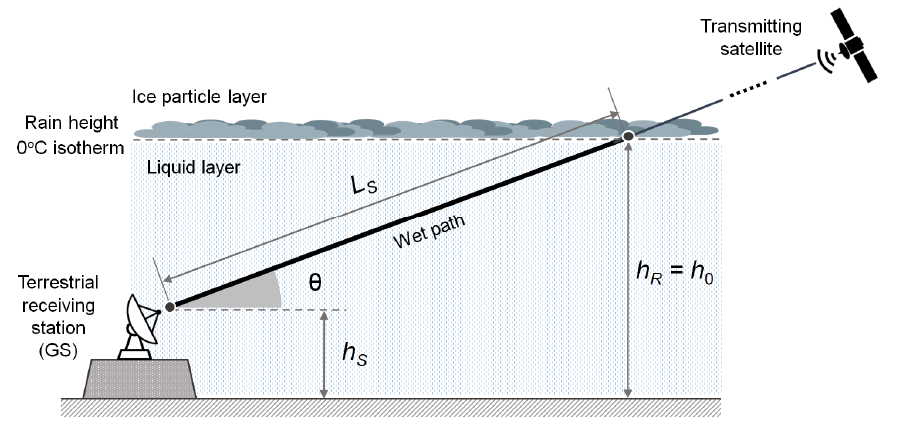
Figure 1. Satellite downlink geometry in the presence of stratiform rain and two-layer tropospheric model.